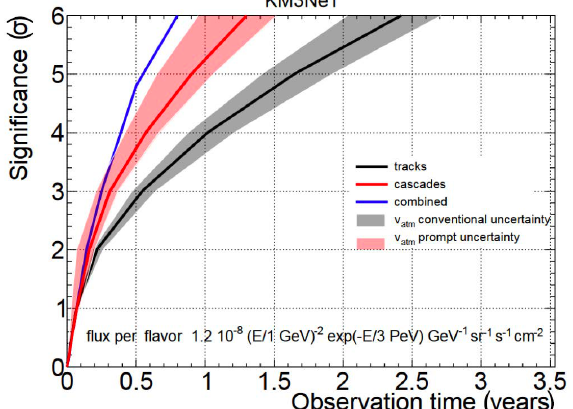
Figure 5. Significance as a function of the Cubic Kilometre Neutrino Telescope (KM3NeT)-ARCA (two building blocks) observation time for the detection of a diffuse flux of neutrinos corresponding to the signal reported by IceCube for the cascade channel (red line) and muon channel (black line). The black and red bands represent the uncertainties due to the conventional and prompt components of the neutrino atmospheric flux. The blue line represents the results of the combined analysis.